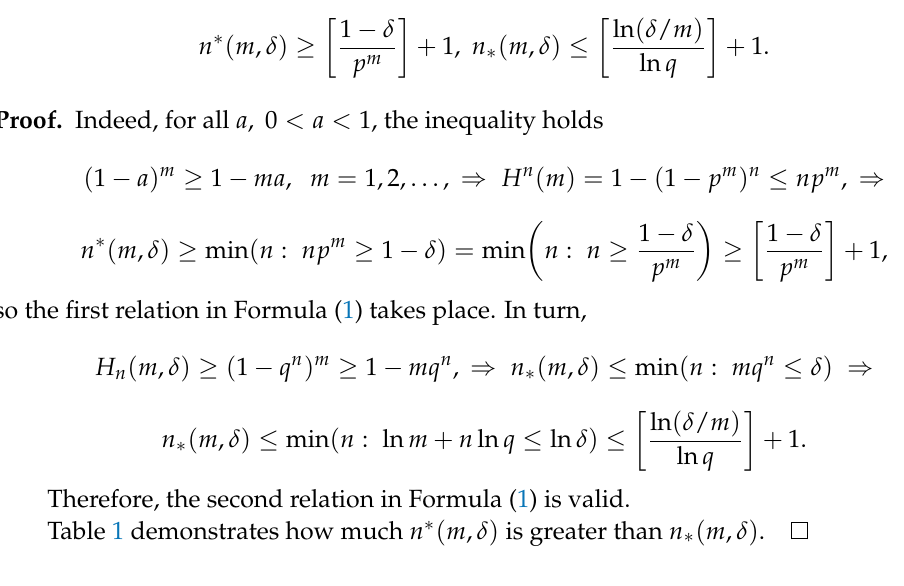
Table 1. Meanings of n ∗ ( m , δ ) , n ∗ ( m , δ ) for p = 0,7, δ =